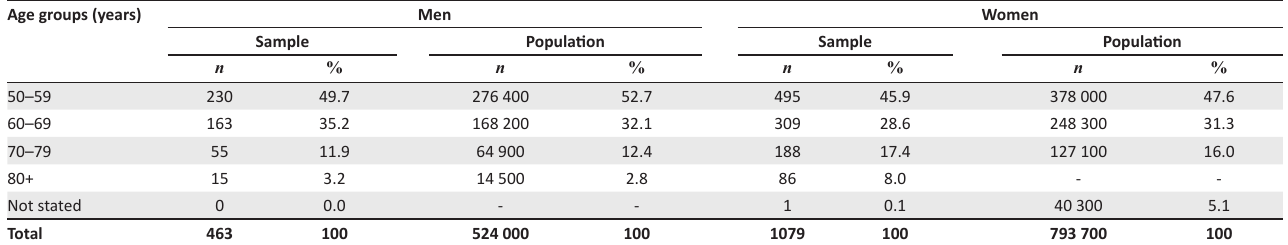
TABLE 1: Age and gender composition of examined participants in relation to the population in the survey area. Age groups (years)